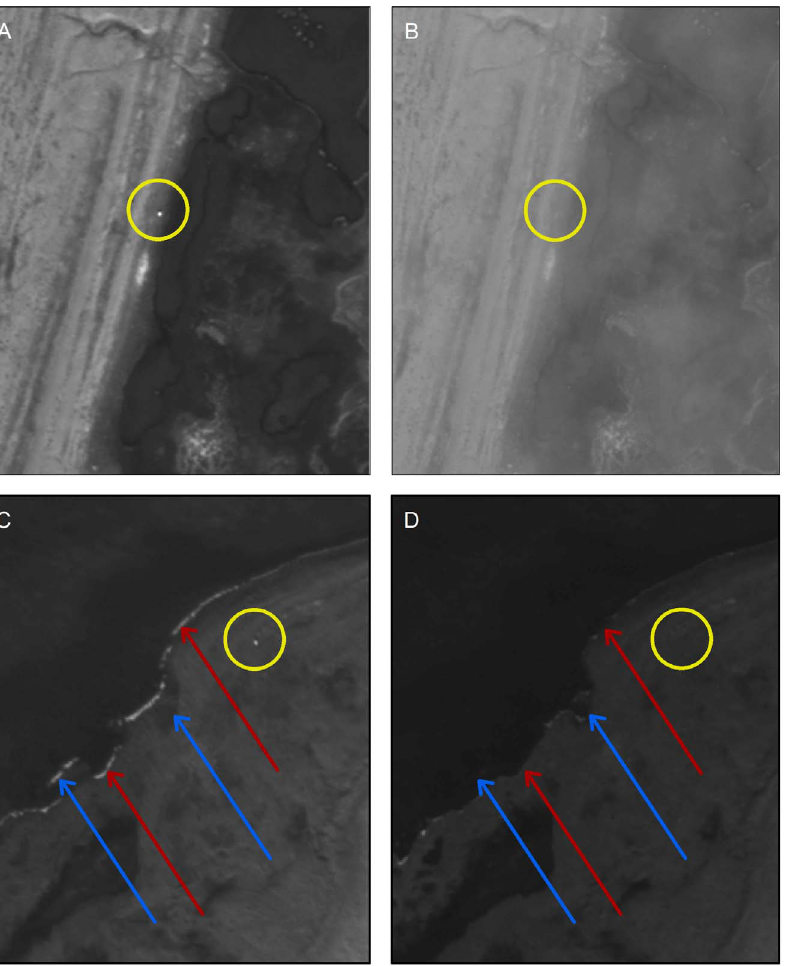
Figure 3. Clouds (top) and water conditions (bottom) are factors that may hamper detection of bears. Bear locations are indicated in target [(a) and (c)] and reference [(b) and (d)] images with yellow circles. Foam accumulating along the edges of water bodies and changes in water levels between target and reference images are indicated in the bottom pair of shots by red and blue arrows, respectively. Satellite imagery printed under a CC BY license, with permission from DigitalGlobe (cid:2)